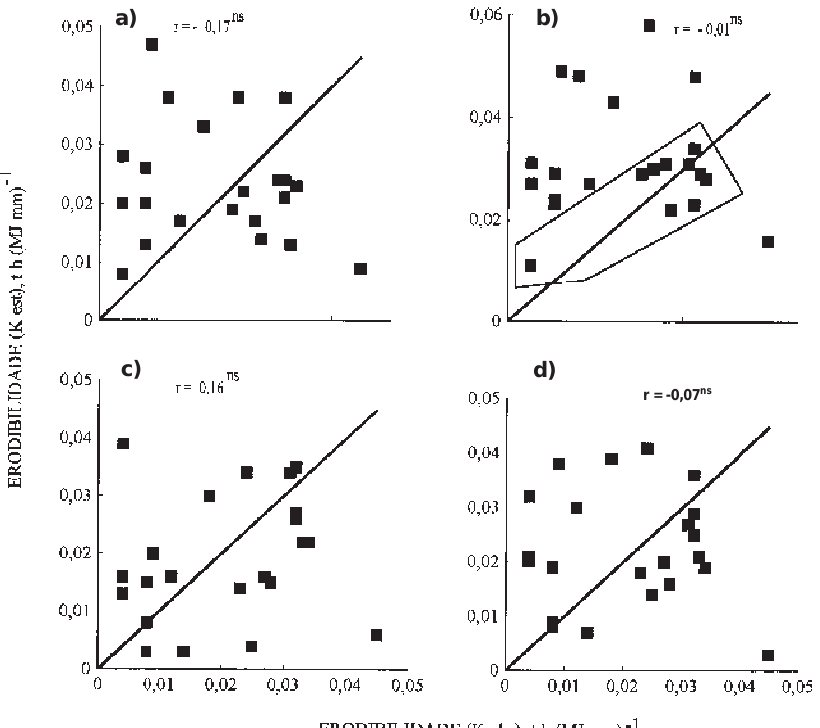
Figura 2. Relação entre o K estimado (K est.) pelos métodos 1 (a), 2 (b), 3 (c) e 4 (d) e o K observado (K obs.). O traço contínuo representa a linha 1:1 (ns = não